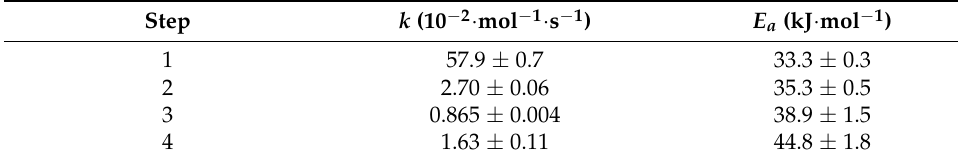
Table 2. The input variables and objectives of Summit SnAr.